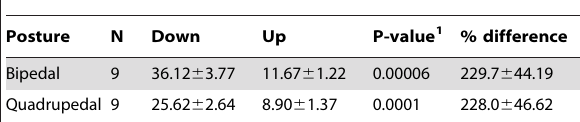
Table 4. Mean values and standard errors of work (J) done from bipedal and quadrupedal posture when striking downward and